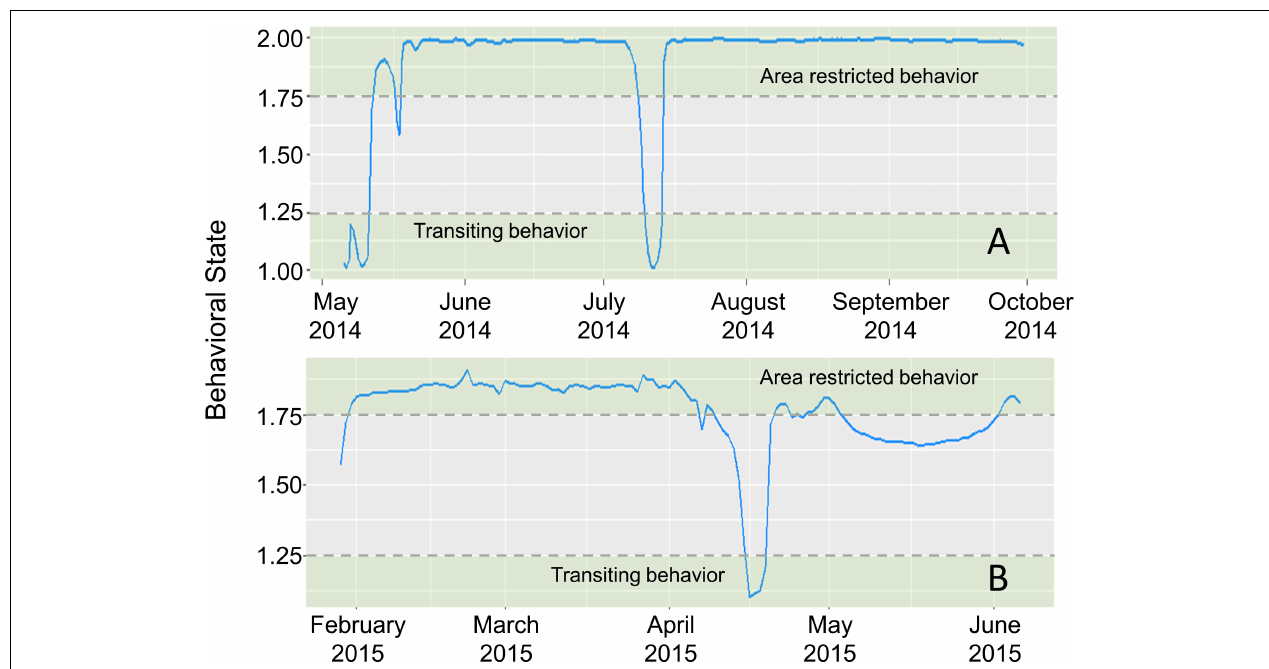
FIGURE 4 | Time series of estimated mean behavioral state (blue line) for scalloped hammerheads ID4 (A) and ID28 (B) , estimated in a first-difference correlated random walk switching model. Dashed horizontal lines indicate thresholds for defining behavioral states (green shaded areas) (area-restricted behavior: > 1.75, transiting behavior: < 1.25).